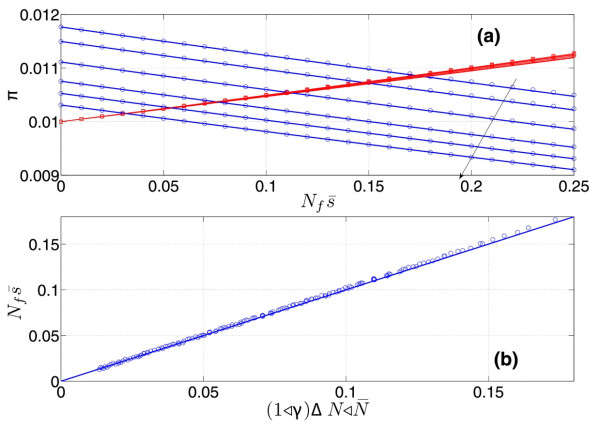
Criterion for Altruists selection. ( a) fixation probabilities πs (red squares) and πA (blue circles) as a function of selection pressure Nfs¯, for Nf = 100 and Ni=85,87,90,93,95,97. Values are obtained by numerically solving eq.(8). Solid lines are theoretical values (eqs. 13,14). Increasing Ni are indicated by the arrow. (b) equilibrium selection pressure Nfs¯∗ for which πA = πs for multiple combinations of Nf∈100,150 and Ni∈85,148, as a function of relative population increase, obtained numerically. The solid line is the theoretical value (eq.15).